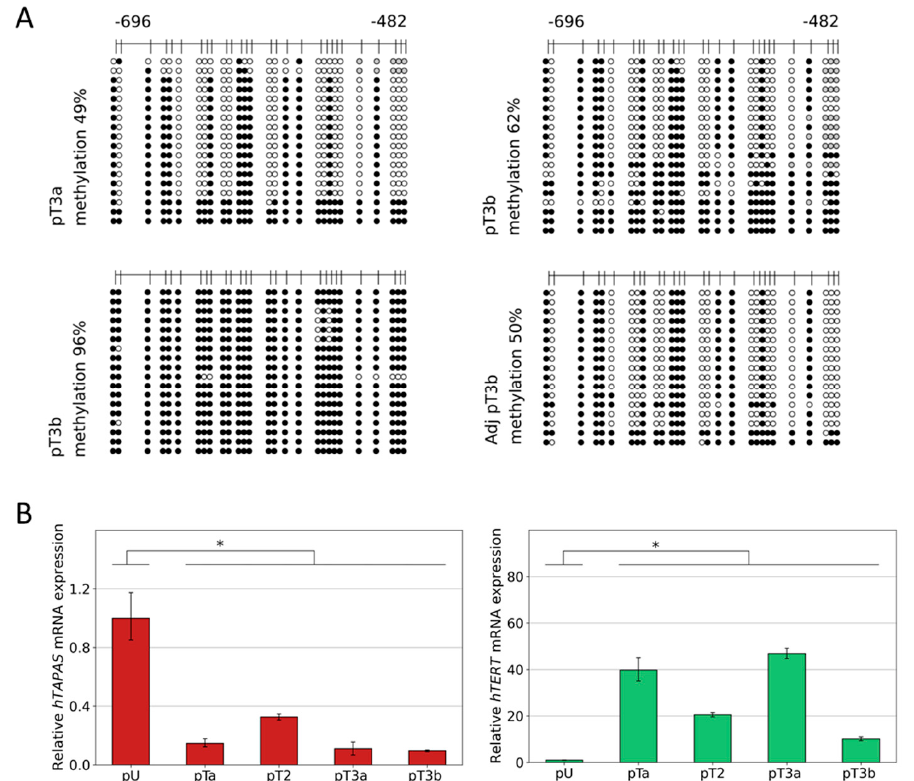
Figure 3. Relative hTAPAS and hTERT gene expression and detailed DNA methylation profiles of the THOR region in urothelial cancer. The detailed DNA methylation patterns of a 215 bp 5 ′ -fragment within THOR, ranging from − 482 to − 696 relative to the translational start site of the HTERT gene, was determined from one pT3a, one pT3b, and one pT3b, and its adjacent benign urothelial tissue sample. Here, every unmethylated CpG dinucleotide is represented by a blank circle, every methylated one by a black circle, and non-defined CpG positions are depicted by grey circles ( A ). In addition, two samples of primary urothelium and samples of one pTaLG, one pT2, one pT3a (49% methylation), and one pT3b (96% methylation) were used to measure the expression of the lncRNA hTAPAS and HTERT genes, * p ≤ 0.05 ( B ).